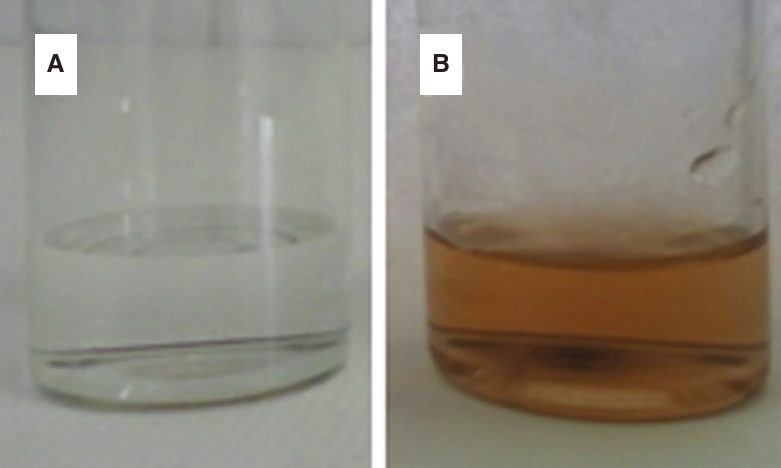
and A. fumigatus mycelia extract (A) at the beginning of heating 3